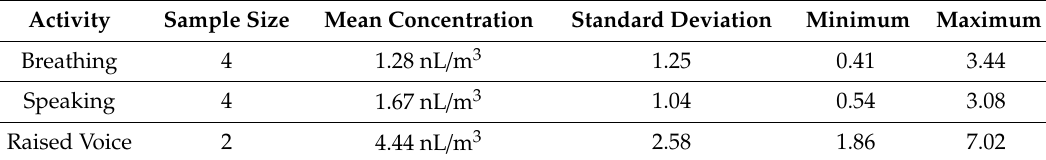
Table 2. Explanation of the letters in Figure 3.